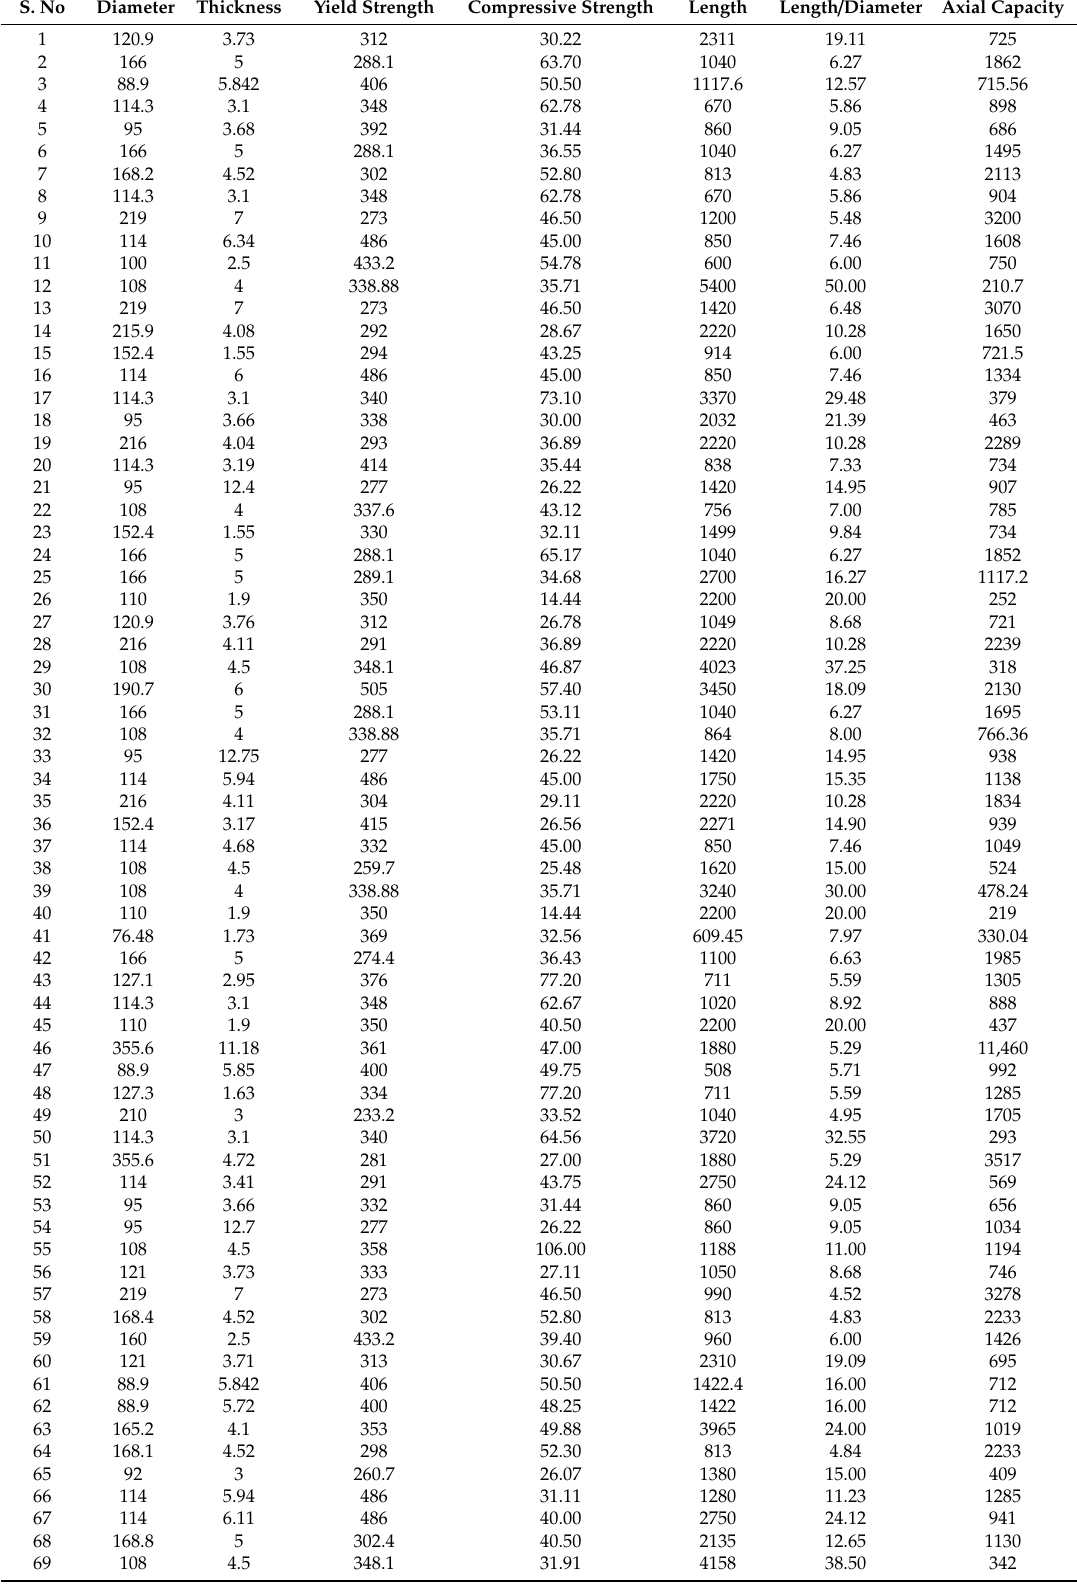
Table A1. Data used to model concrete-filled steel